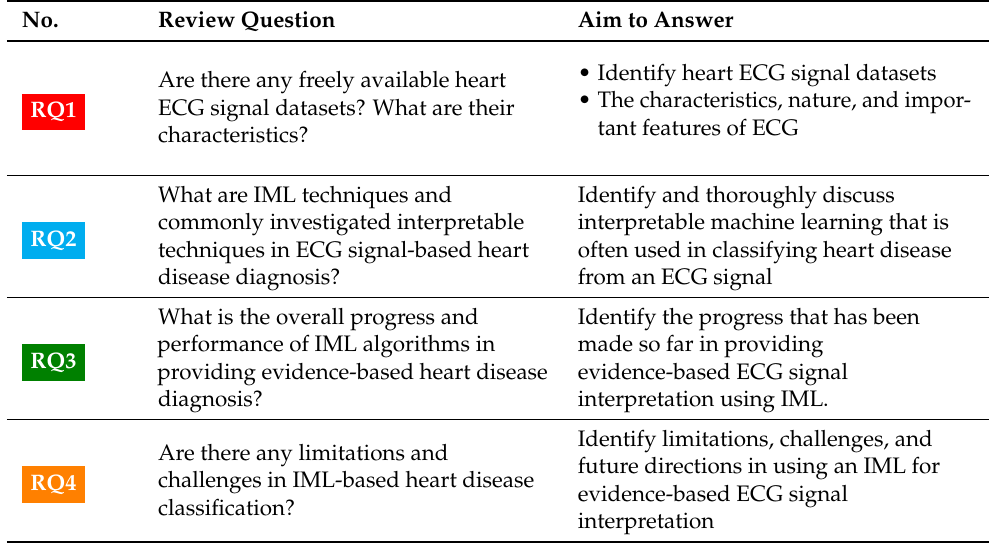
Table 2. Review questions with main